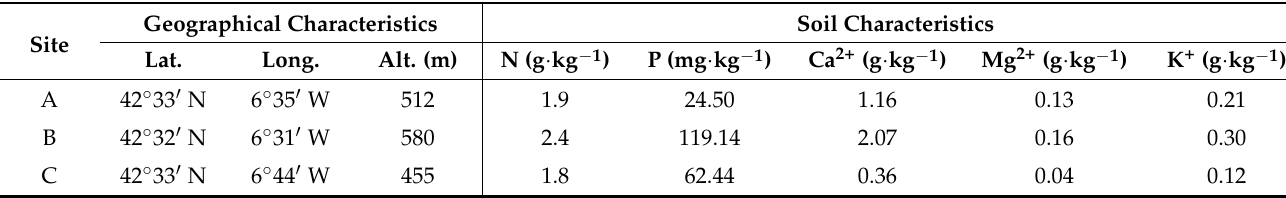
Table 1. Geographical and soil characteristics of the sites where pepper plants were grown. Geographical Characteristics Soil Characteristics Site